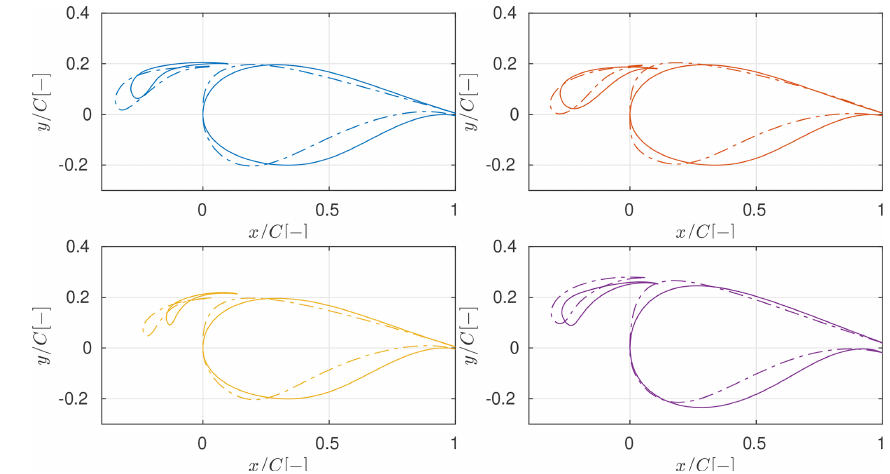
Figure 14. Comparison of profiles obtained using the auxiliary ( − ) and the integral ( − . ) design